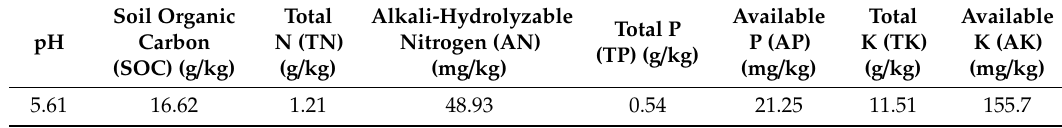
Table 1. The initial soil properties of the studied site.